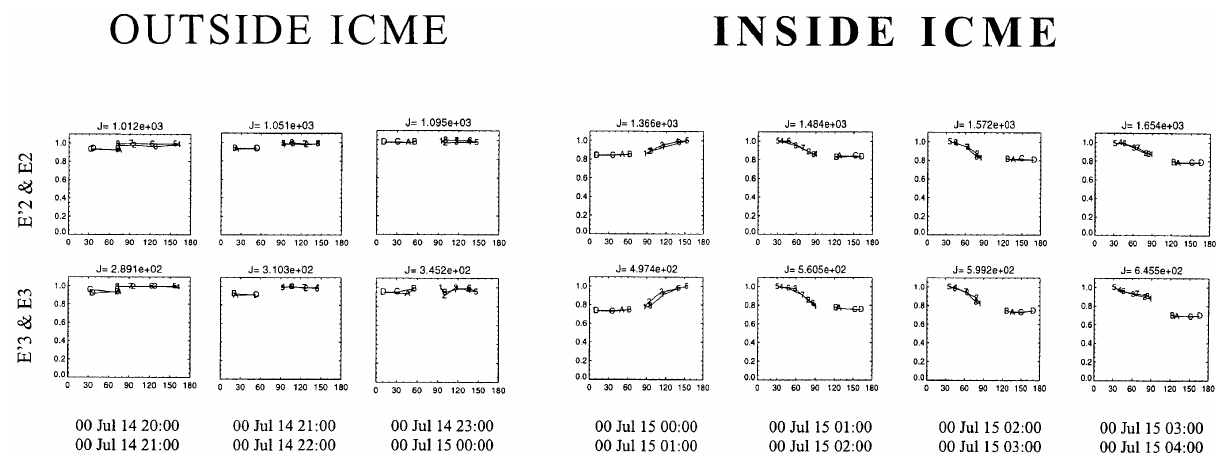
Fig. 6. Representative snapshots of the electron pitch-angle distributions observed inside and outside the high-latitude ICME by the ULYSSES/HI-SCALE instrument in July 2000 (E 0 2: 65–112keV, E 0 3: